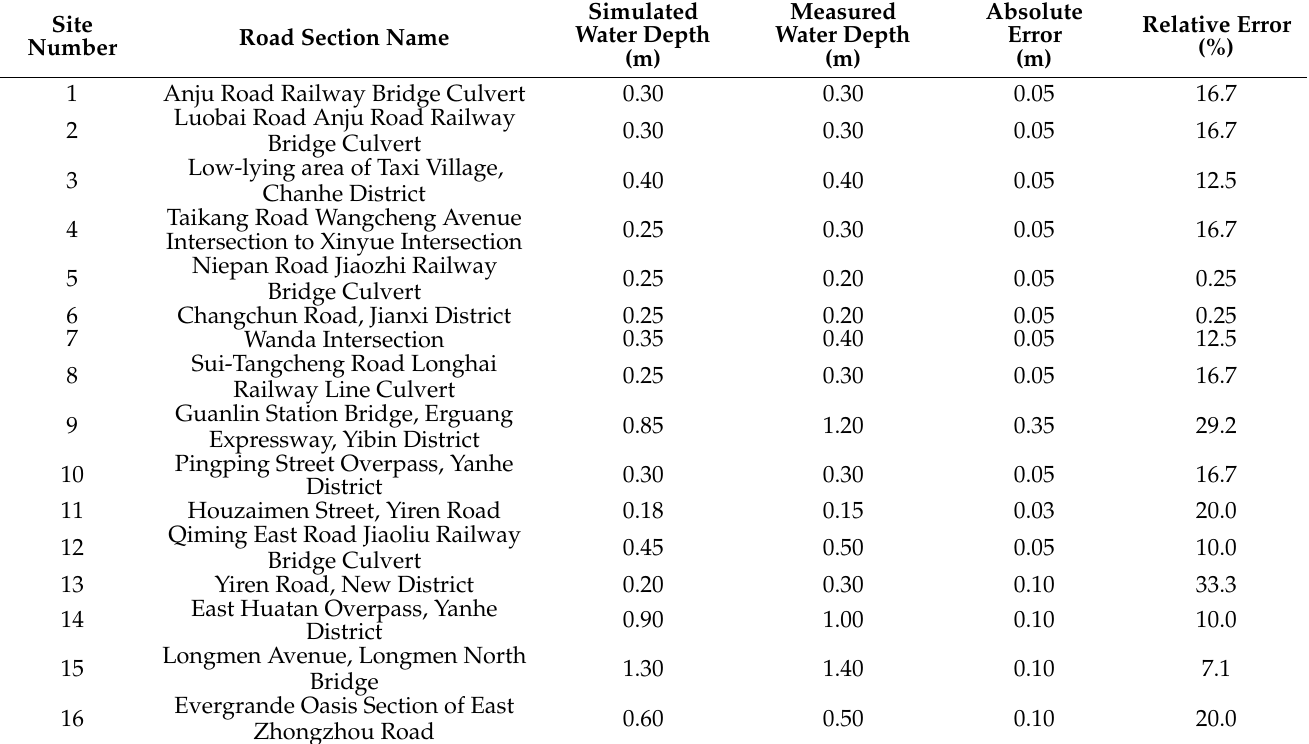
Table 3. Table of simulation results of flooding depth of water accumulation point in storm